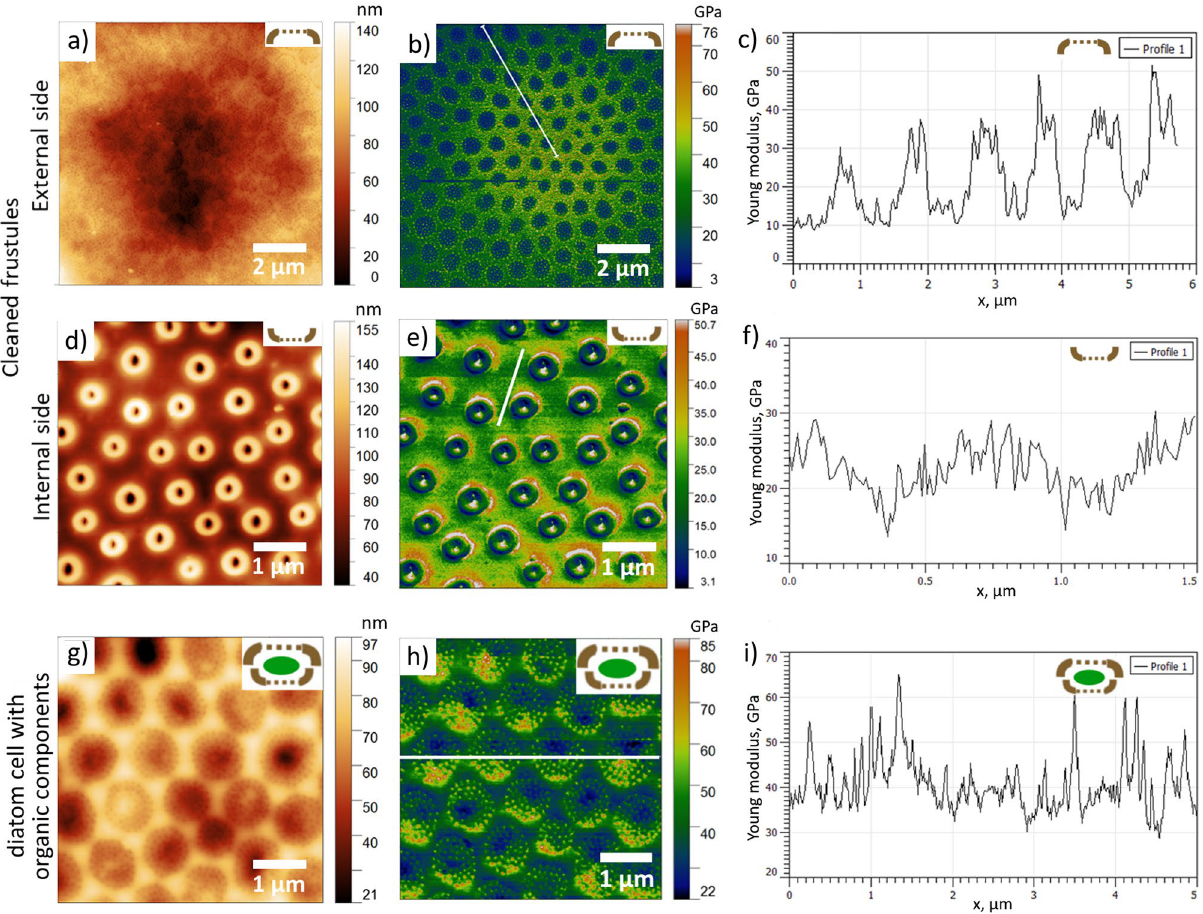
Figure 5. The AMFM study of cleaned frustules and wet diatom cells. External side of the cleaned valve: ( a ) Topography, ( b ) The AMFM Young modulus, ( c ) The AMFM Young modulus profile along the white line shown in ( b ). Internal side of the cleaned valve: ( d ) Topography, ( e ) The AMFM Young modulus, ( f ) The AMFM Young modulus profile along the white line shown in ( e ). External side of the wet diatom cell: ( g ) Topography, ( h ) The AMFM Young modulus, ( i ) The AMFM Young modulus profile along the white line shown in ( h